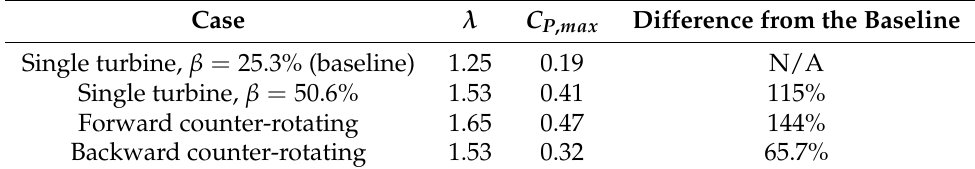
Figure 19. The power curves of the configurations displayed in Figure 16 and their associated blockage ratios. Table 4. Summary of the maximum power points of the 4